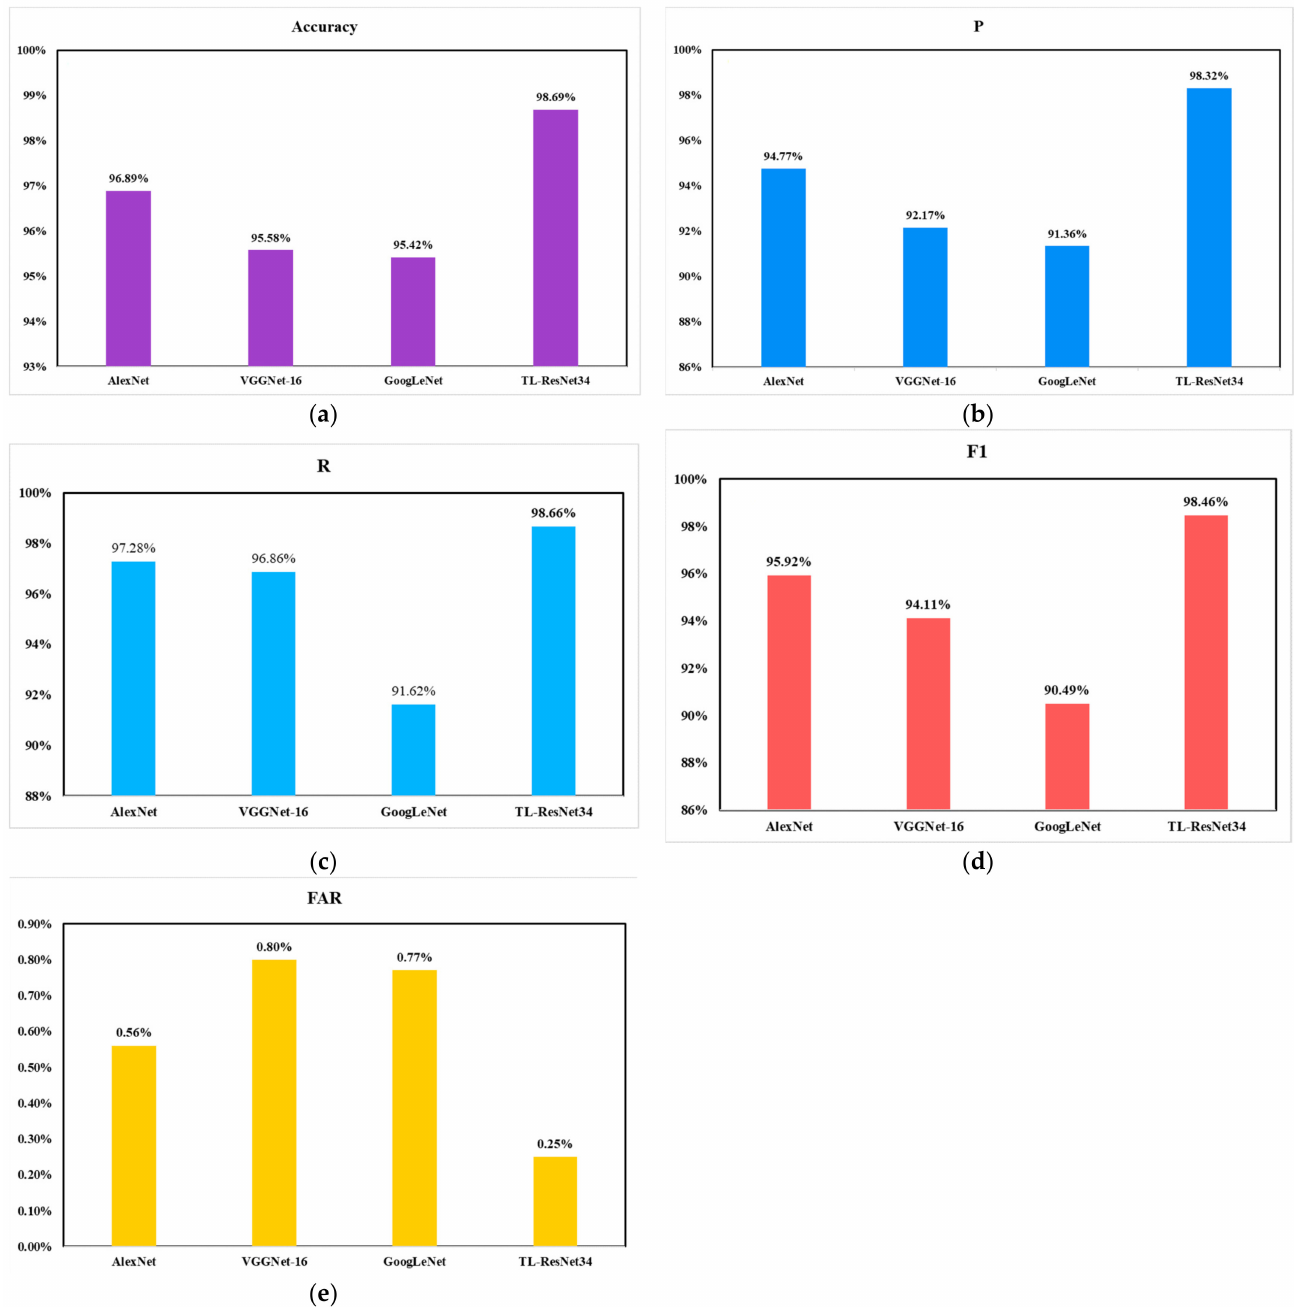
Figure 6. Recognition accuracy of four different models: ( a ) Accuracy; ( b ) Precision; ( c ) Recall; ( d ) F1-Score; ( e ) False Accept